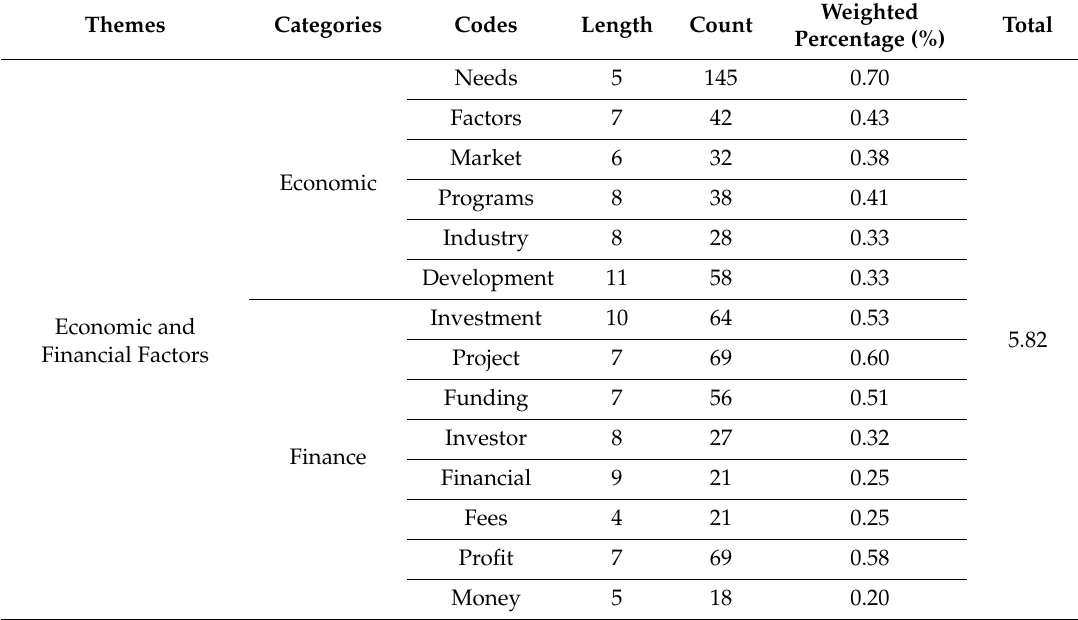
Table 5. Word frequencies for economic and financial factors